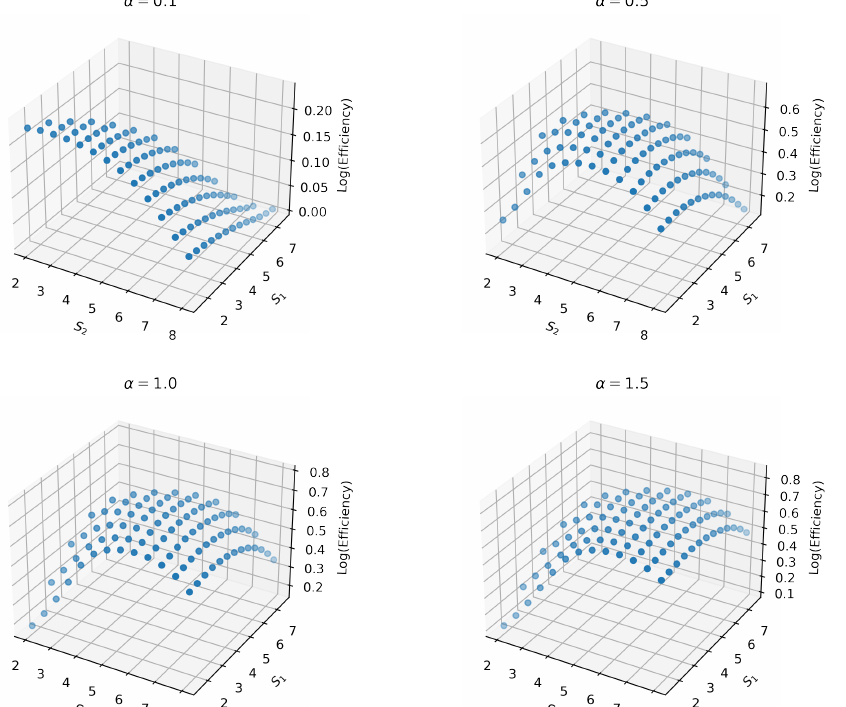
Figure 12. The maximum efficiency for the Otto cycle that works among two adiabatic curves, s 1 < s 2, is displayed in Figure for α = 0.1,0.5,1, and 1.5.